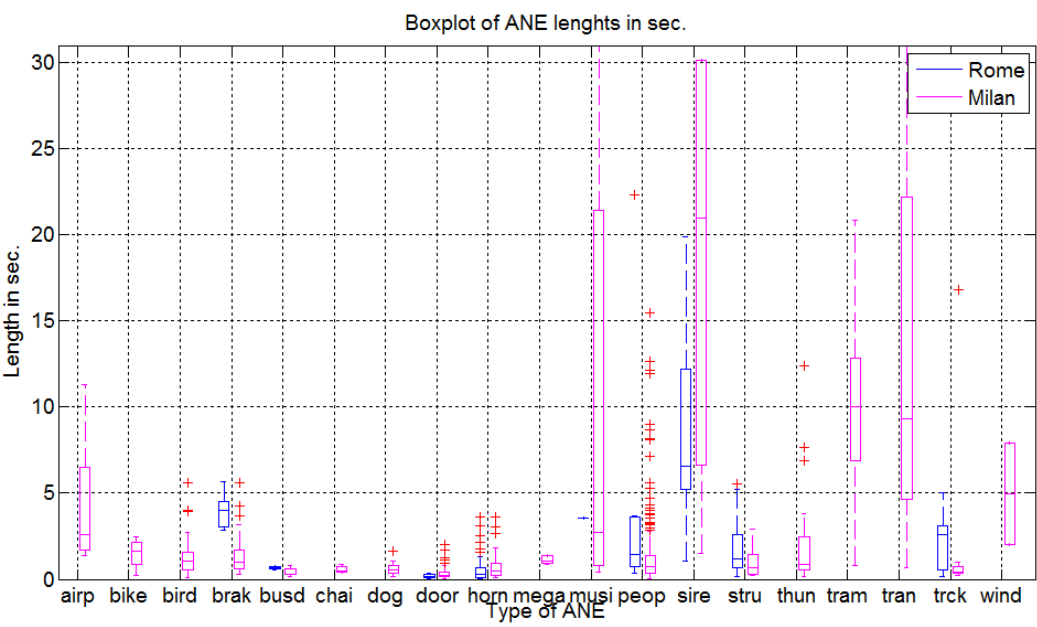
Figure 9. Boxplots of the durations of each ANE type per category differentiating both locations Rome (suburban) and Milan